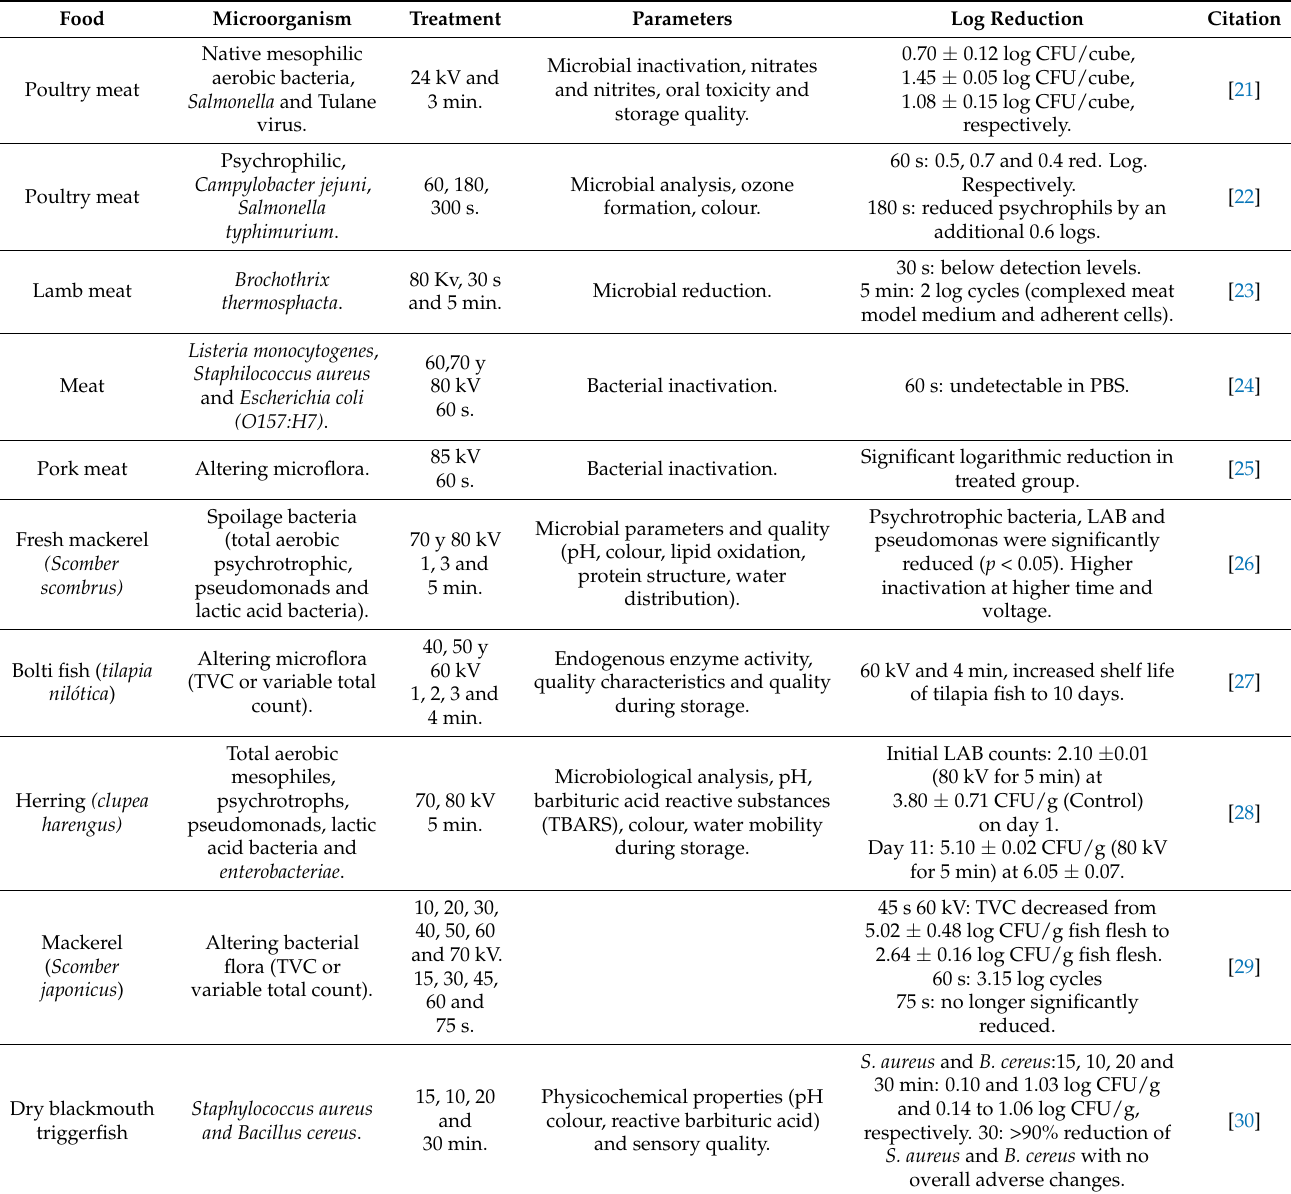
Table 1. Meat and fish treated with DBD cold plasma at atmospheric pressure and ambient